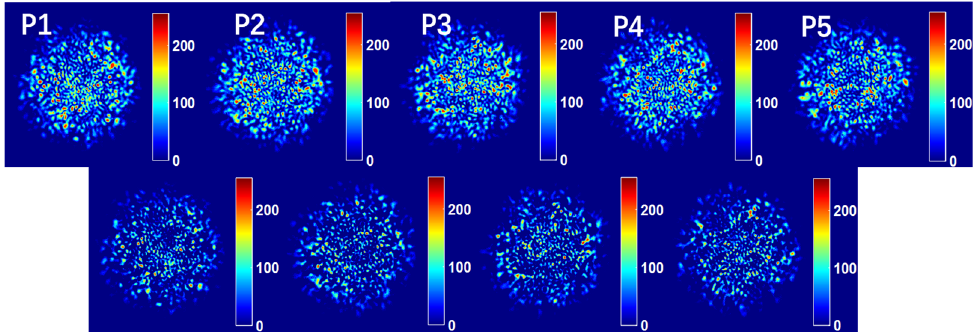
Figure 5. Speckle patterns corresponding to the same curvature collected from different positions and their differences between the adjacent speckle patterns.